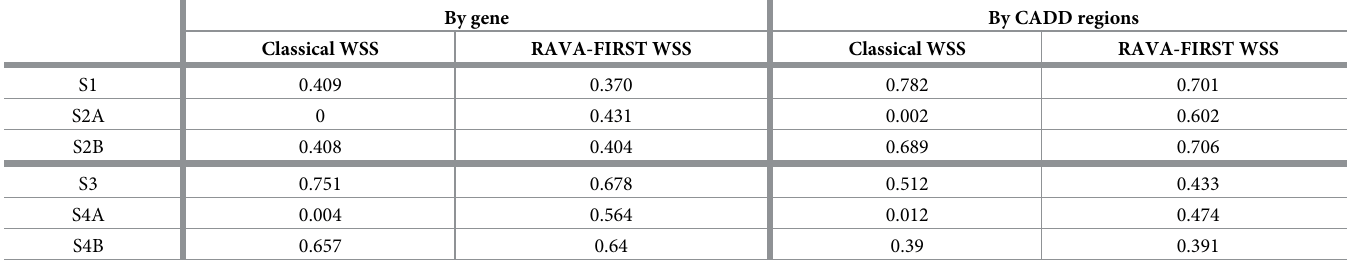
Table 3. Power at the genome-wide significance level of 2.5 � 10 − 6 under the different simulation scenarios using either the classical WSS or the RAVA-FIRST WSS at the scale of either the entire gene or CADD regions. By